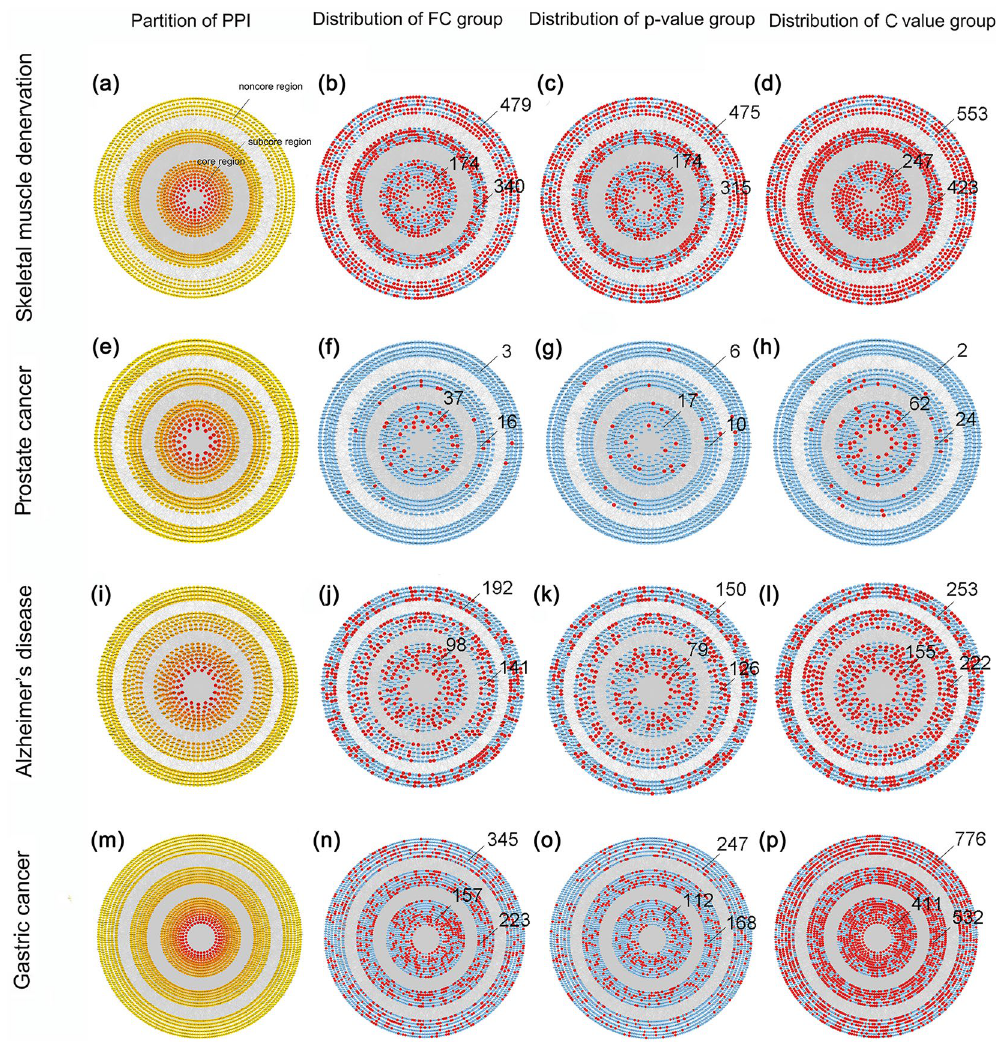
Figure 2. Partition of PPI network and distribution of each group in PPI network. ( a , e , i , m ) PPI network of DEGs in the Skeletal muscle denervation dataset, Prostate cancer dataset, Alzheimer’s disease dataset and Gastric cancer dataset. The degree of each node was calculated. The larger the degree of the node, the darker the color and the closer the position is to the center. The top 20% nodes are defined as core regions, the top 20%- 50% nodes are defined as sub core regions, and the remaining nodes are noncore regions. ( b , f , j , n ) Distribution of FC group in PPI network. ( c , g , k , o ) Distribution of p-value group in PPI network. ( d , h , l , p ) Distribution of C value group in PPI network. Red is the selected node, blue is the unselected. Number of genes in core region, sub core region and noncore region of each group has been tagged. STRING v11.0 was used to generate protein interactions, and the resulting network was visualized using Cytoscape v3.7.2. (FC group: the collection of the top10 FC miRNAs’ predictive target mRNAs; p-value group: the collection of the top10 p-value miRNAs’ predictive target mRNAs; C value group: the collection of the top10 C value miRNAs’ predictive target